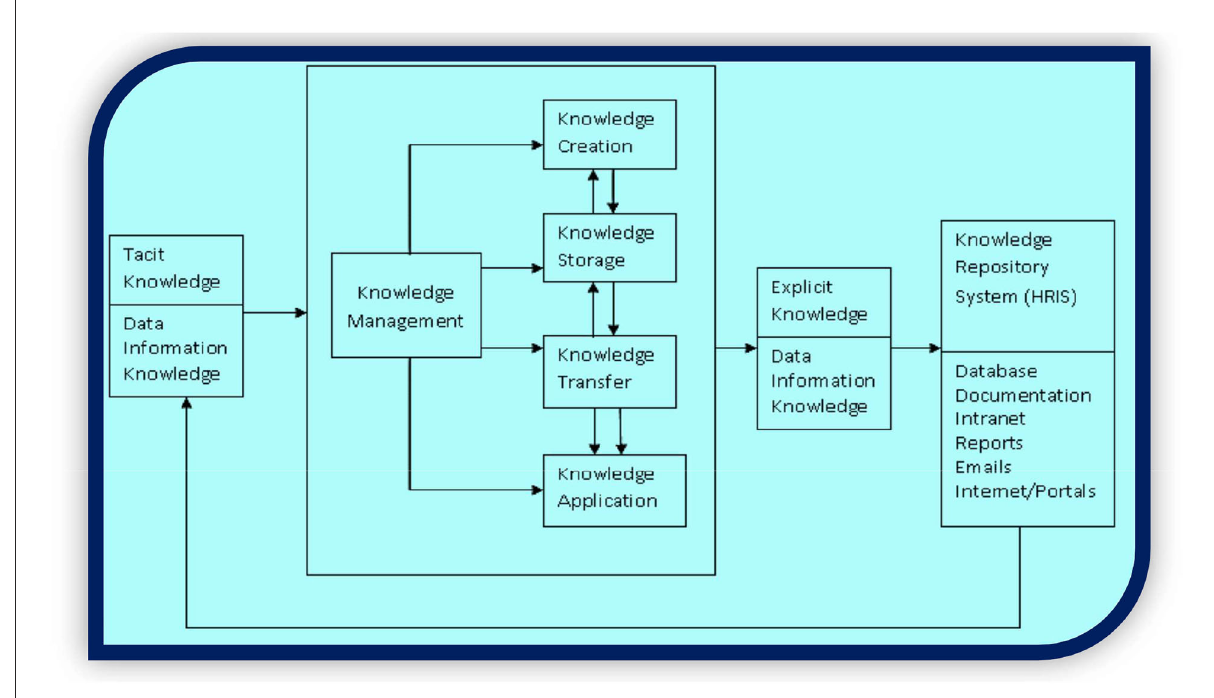
FIGURE4 Knowledge repository system (HRIS; source: authors, based on Alavi and Leidner, 1999; Laakso-Manninen and Viitala, 2007; Gedam,